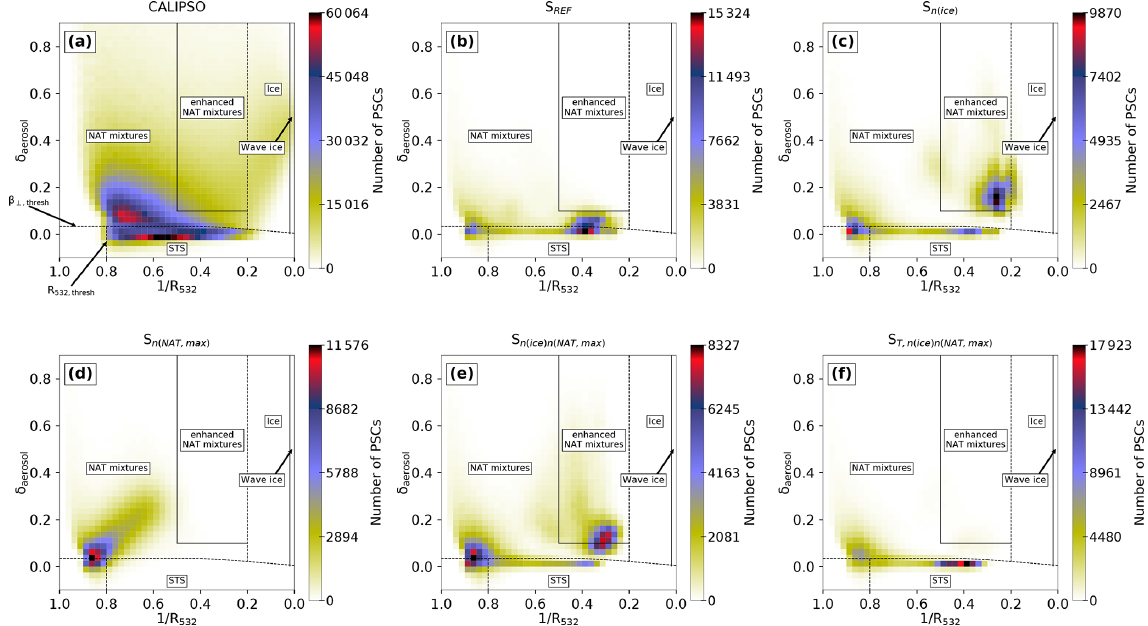
Figure A7. Composite 2D histograms of CALIPSO measurements and SOCOL simulations as in Figs. 1, 6 and A2, but for the year 2006.